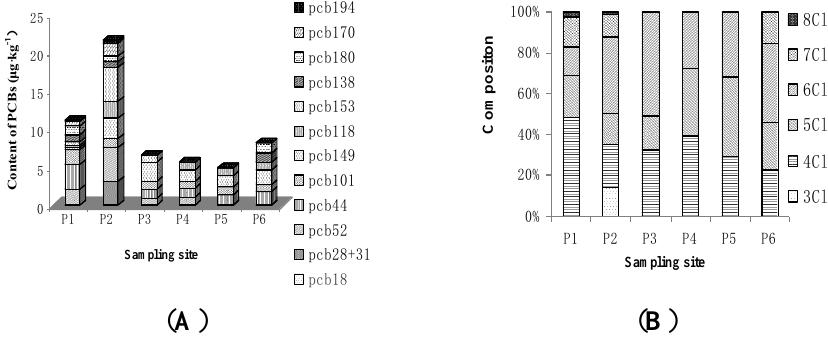
Figure 2. Characterization (( A ) dry weight basis) and composition ( B ) of PCBs in paddy soil